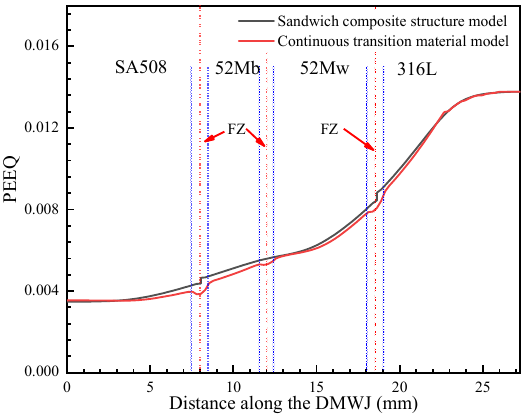
Figure 13. Stress along the DMWJ under an axial load and internal pipe pressure.